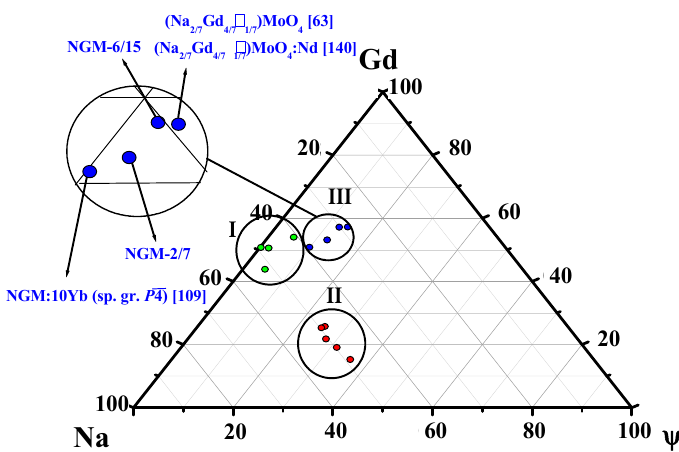
Figure 3. Region of existence of phases with the general composition (Na,Gd, ψ )MoO 4 with ψ = 0, (cid:3) (vacancy), Yb, La. Region III with defective and ordered structures is highlighted.